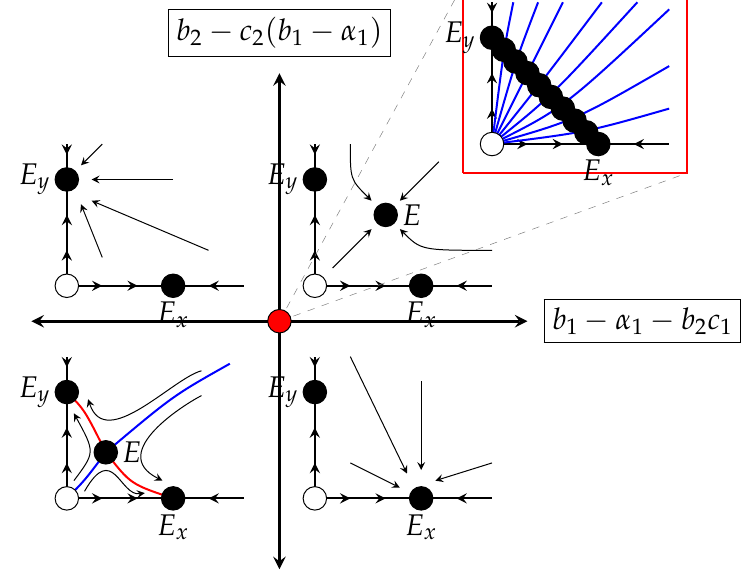
Figure 3. Global dynamics of System